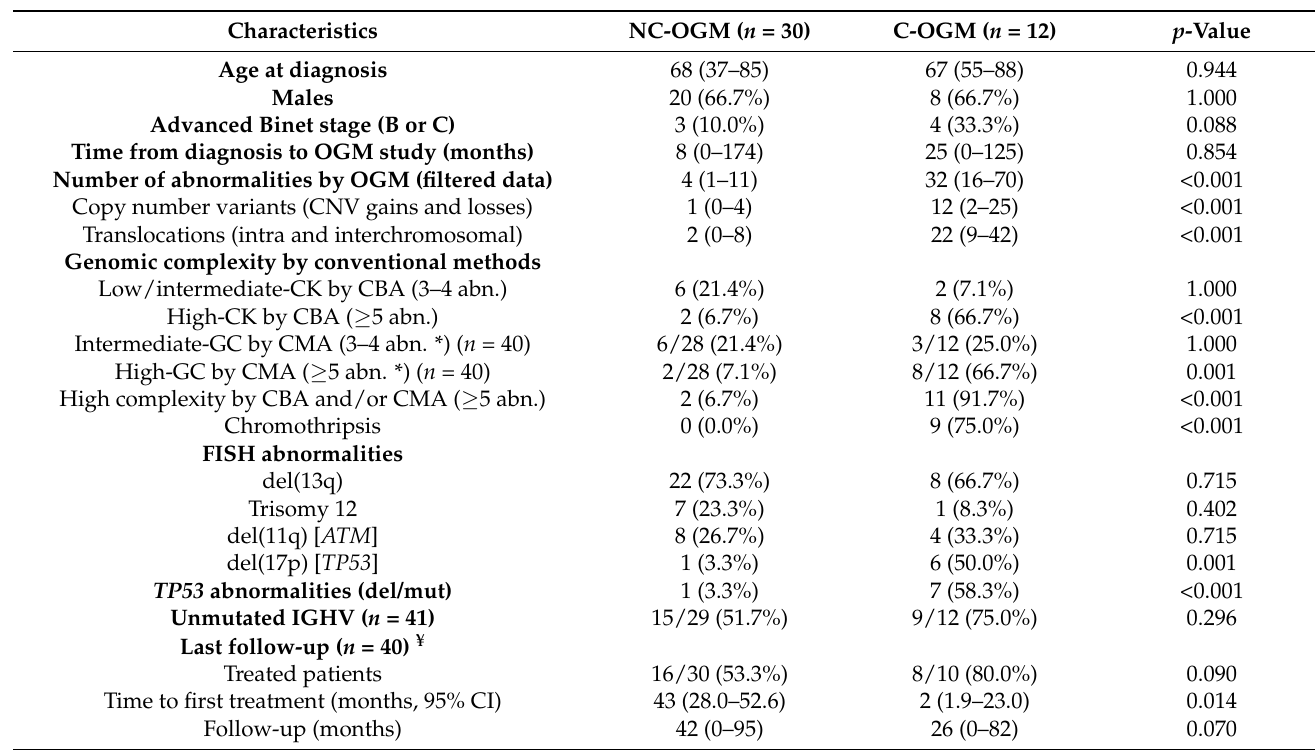
Table 3. Comparison of the clinical and biological characteristics of CLL patients classified according to the genomic complexity detected by